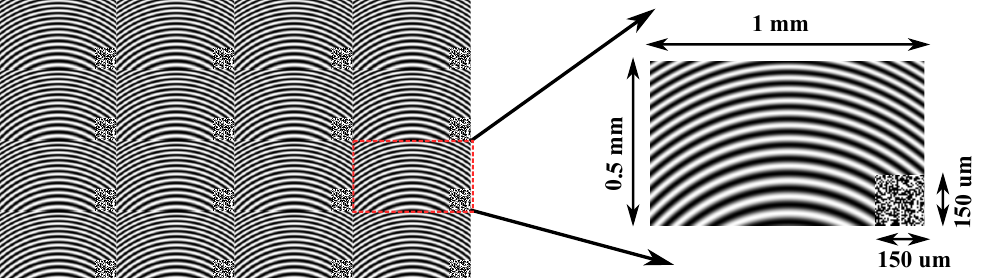
Figure 3. Illustration of the interference pattern used by the wavefront printer. The randomness in the lower-right corner introduces a diffusing area in the final